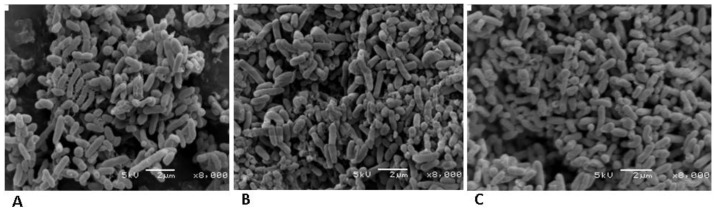
Scanning electron micrograph of strain MWI-1 grown on wastewater liquid media without test metal stressed (A), with vanadium stress (B) and with nickel stress (C).